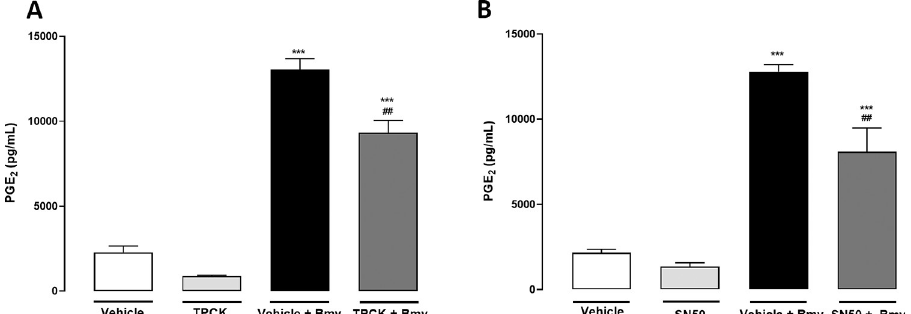
Fig 6. NF- κ B participates in Bmv-induced PGE 2 release by preadipocytes. 3T3-L1 preadipocytes were pretreated with NF- κ B inhibitors (A) TPCK or vehicle, for 24 h or (B) SN50 or vehicle (DMSO < 1%) for 1 h, and then stimulated with Bmv (1 μ g/mL) or DMEM (control) for 24 h. Concentration of PGE 2 present in supernatants was quantified by EIA. Results are expressed as mean + SEM (n = 4). ��� p < 0.001 vs. negative control (vehicle + DMEM); ## p < 0.01 vs. positive control (vehicle + Bmv) (ANOVA and Bonferroni post test).